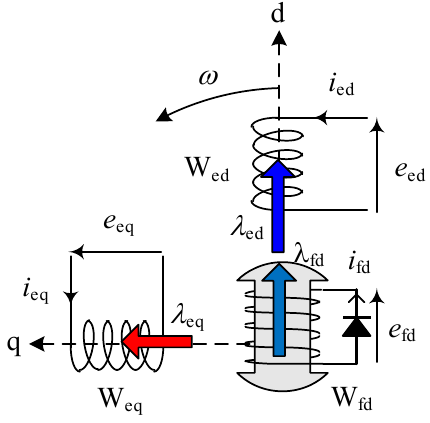
Figure 2. dq-axis model of excitation